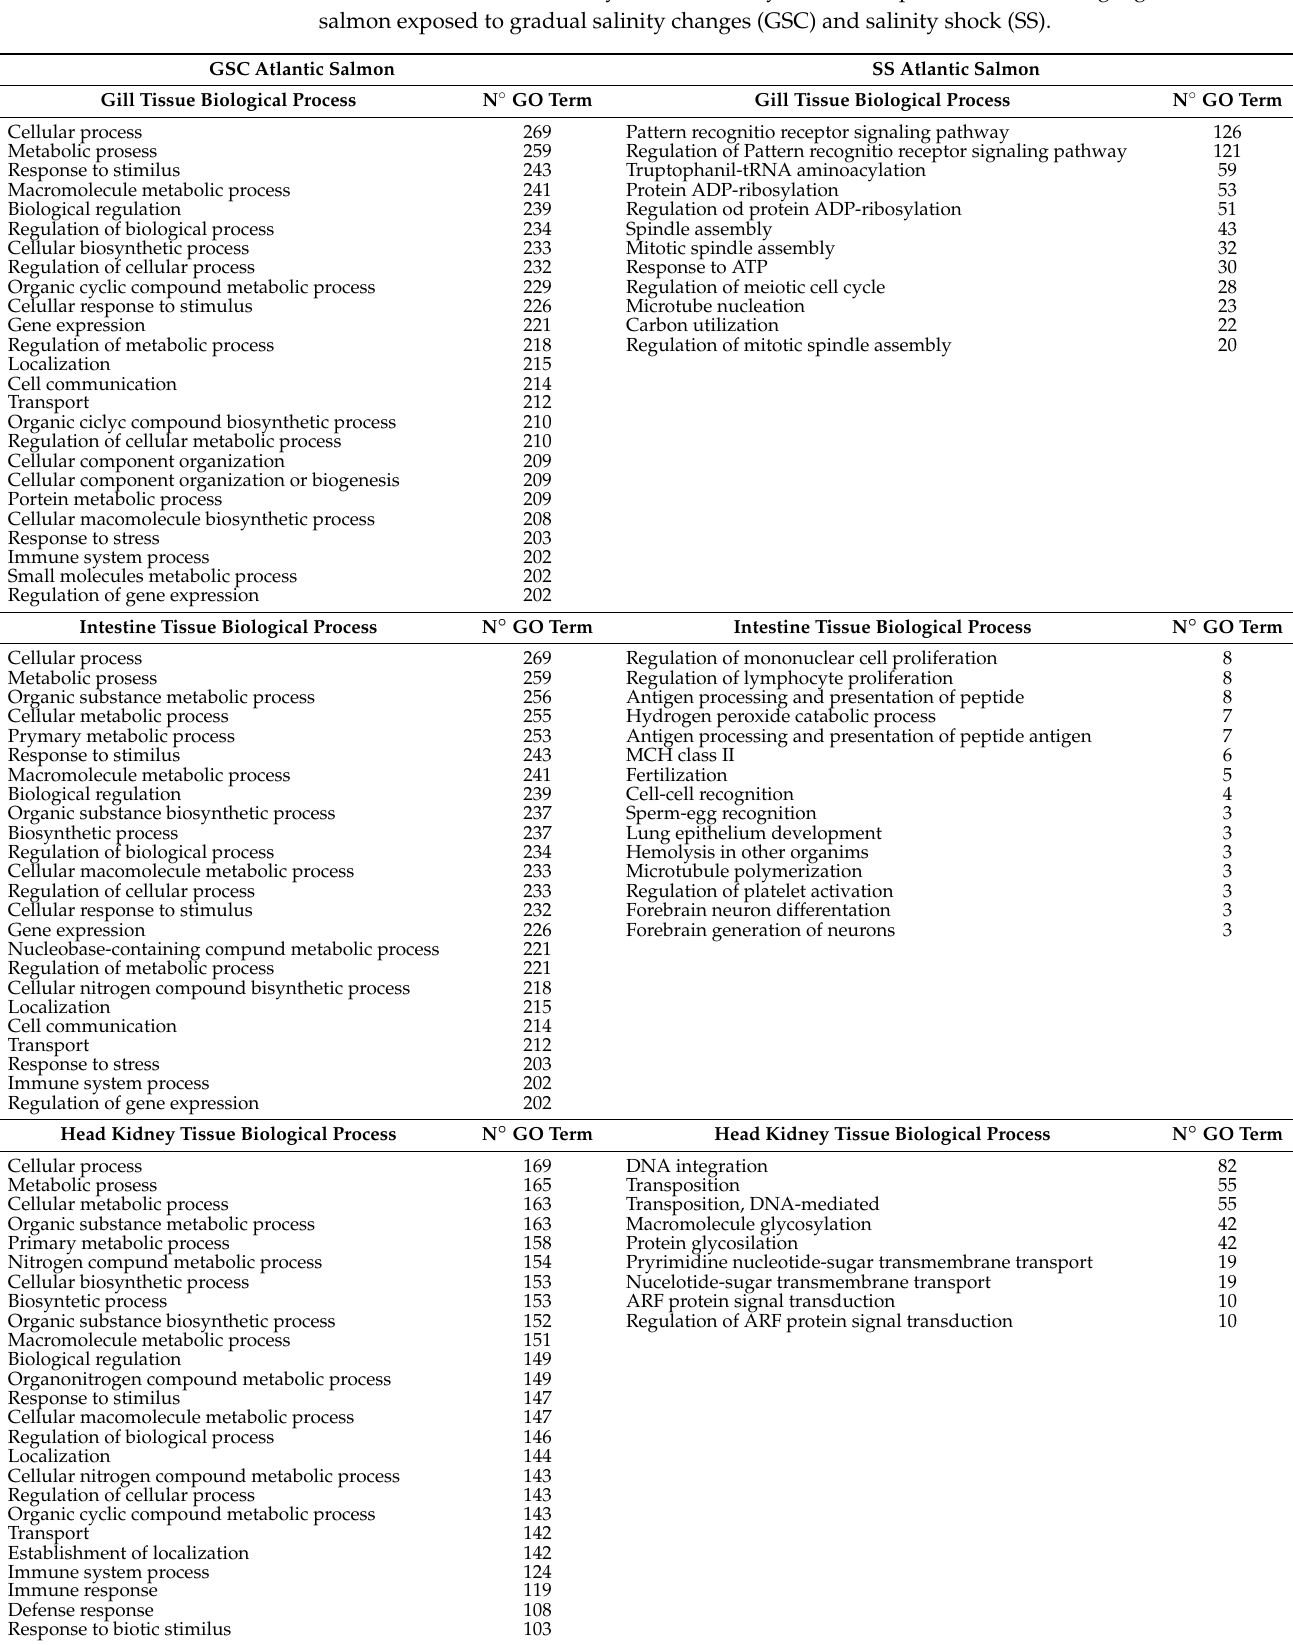
Table 1. GO enrichment analysis of differently modulated putative miRNA target genes in Atlantic salmon exposed to gradual salinity changes (GSC) and salinity shock